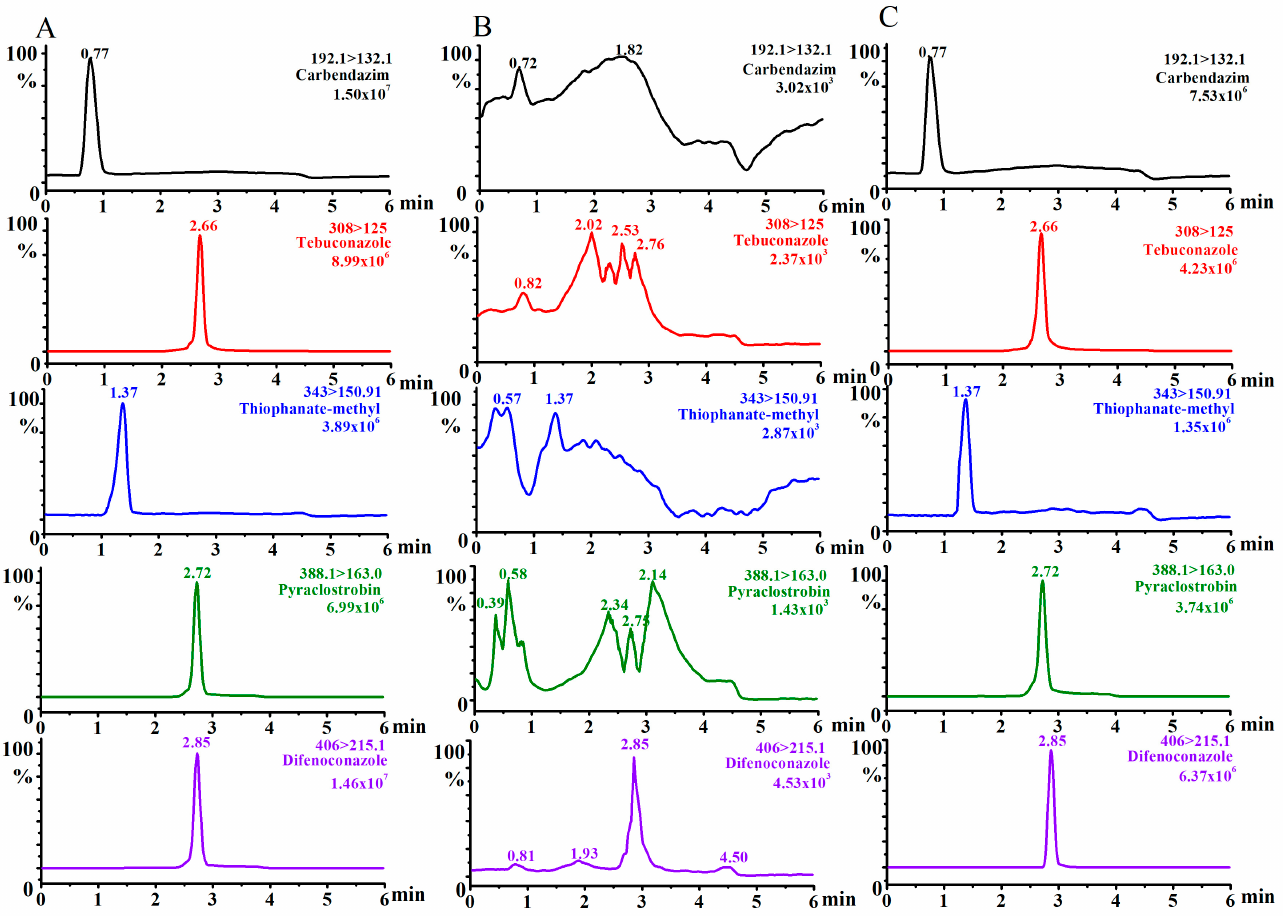
Figure 2. Typical UPLC–MS/MS multiple reaction monitoring chromatograms of the five fungi- cides from the standard solution (0.1 mg/L) ( A ), blank pear sample ( B ), and spiked pear sample (1 mg/kg) ( C